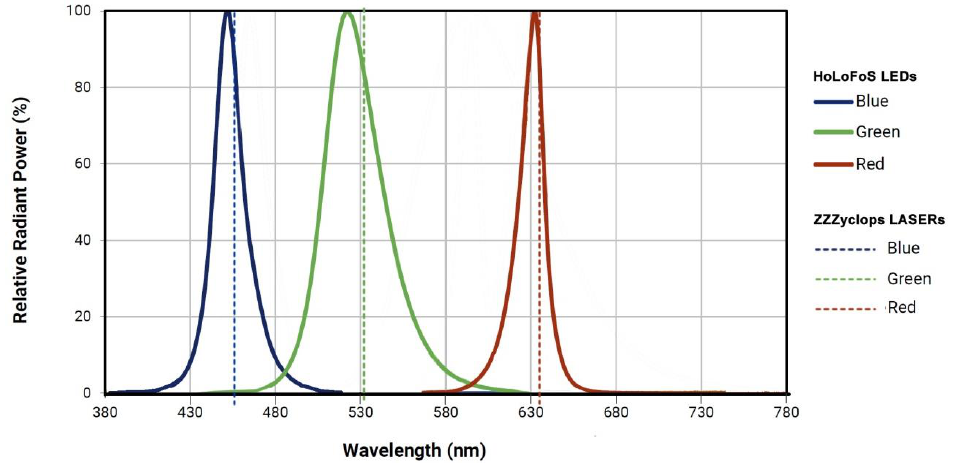
Figure 5. LEDs spectrums of the HoLoFoS TM device and emission lines of the lasers incorporated in ZZZyclops.